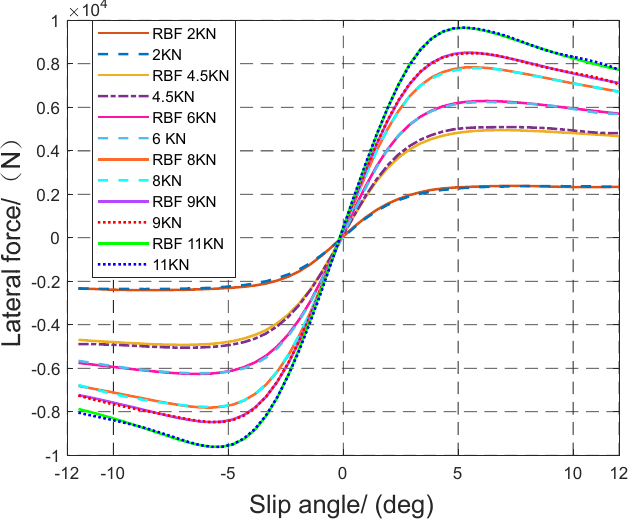
Figure 4. The estimated lateral force of RBF neural networks under different vertical loads.